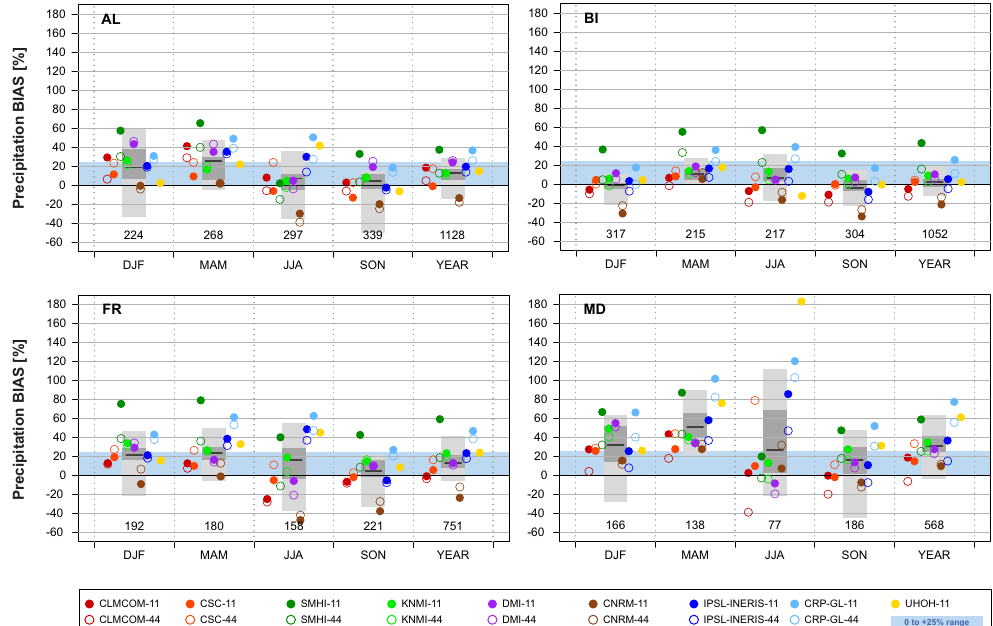
Figure B2. As Fig. B1 but for the mean seasonal and annual relative precipitation bias (BIAS; %). The numbers along the x axis indicate mean seasonal (mmseason − 1 ) and mean annual (mmyear − 1 ) precipitation sums for the period 1989–2008 in the E-OBS reference. The blue shading indicates a bias range between 0 and + 25%, corresponding to acceptable model biases in case of a systematic rain gauge undercatch of up to 20% of true precipitation. See Fig. 6 for subdomains EA, IP, ME and SC.